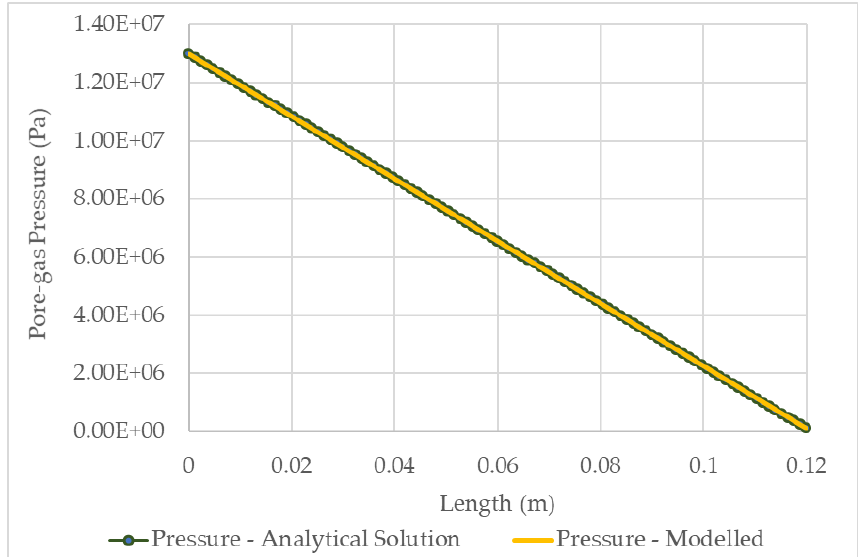
Figure 3. Verification study—1D steady-state solution results for poregas pressure over the length of the specimen.